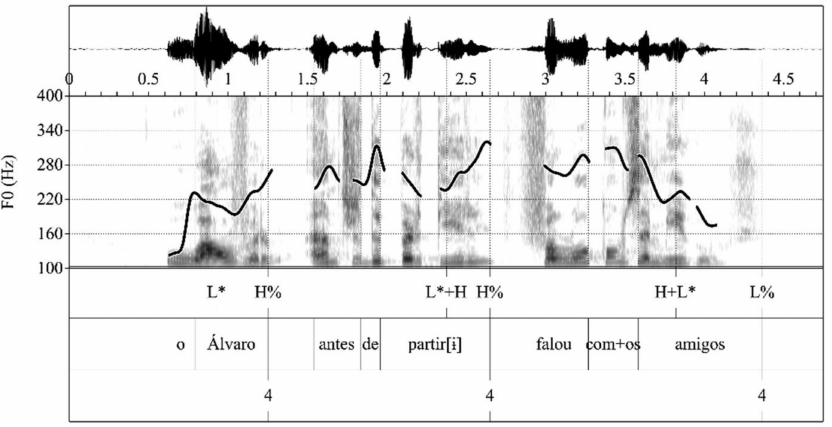
Figure 2. Expected intonational phrase breaks produced by a PD patient.